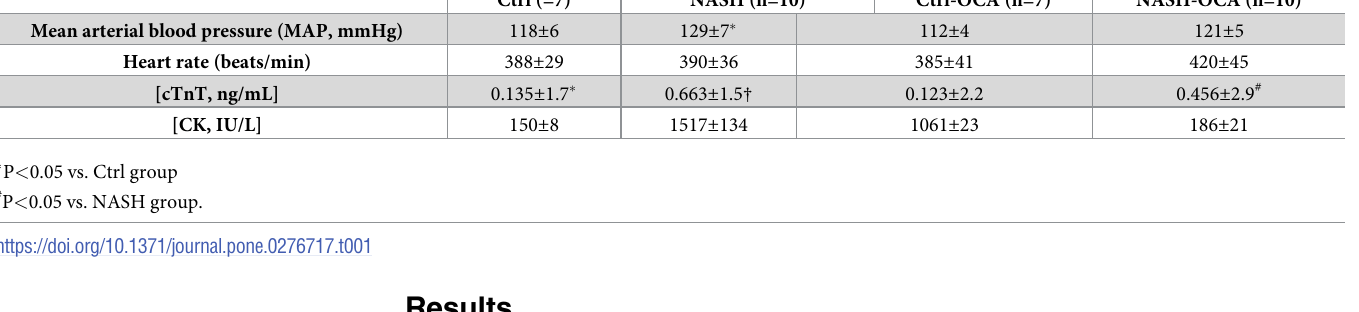
did not change the heart rate and the mean blood pressure in the NASH-OCA mice (Table 1 and Fig 1A and 1B).